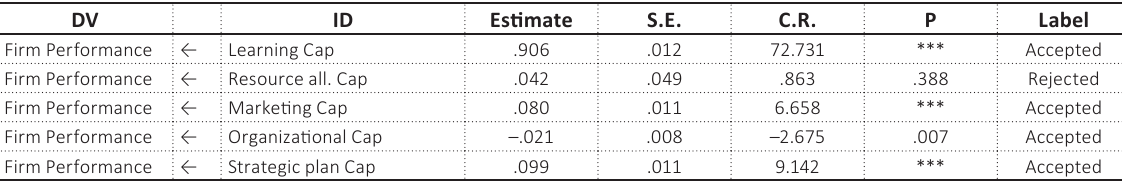
Table 5. Path coefficients and their